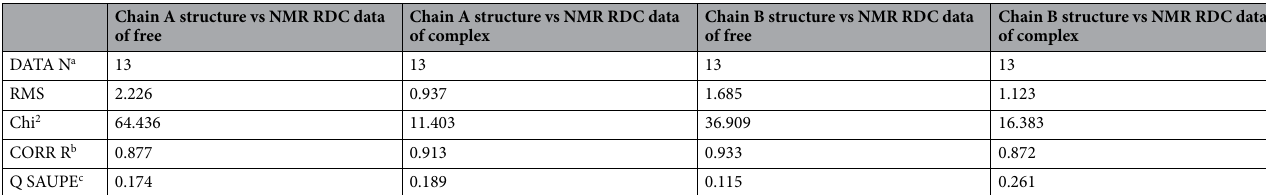
Table 1. The RDC statistics of St14f are computed by PALES. RDCs were obtained by HSQC-TROSY pairs. Three chains A and B in the St14f crystal were used for the PALES analysis. a The number of residues which gave experimental RDC values. b Pearson’s linear correlation coefficient between experimental and best-fitted RDC values. c Cornilescu’s quality factor between experimental and best-fitted RDC